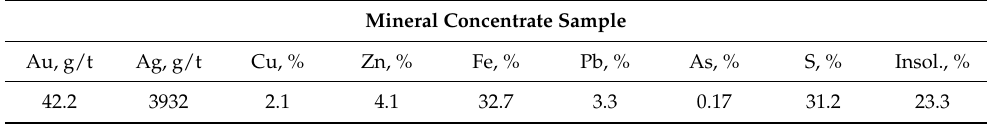
Table 2. Chemical head grade analysis through fire assay (FA) and 4-acid digestion with atomic adsorption finish.